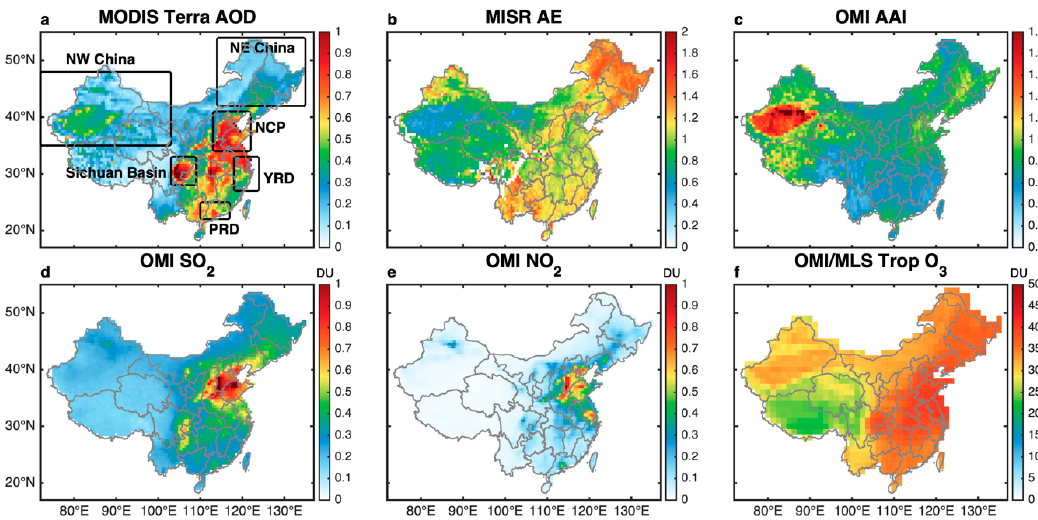
Figure 1. Spatial distribution of annual mean MODIS Terra AOD ( a ), MISR AE ( b ), OMI AAI ( c ), OMI SO 2 ( d ) and NO 2 ( e ), and OMI/MLS tropospheric O 3 ( f ). The black boxes in panel ( a ) indicate the representative regions defined for regional analysis, namely NCP, NE China, NW China, YRD, PRD, and the Sichuan Basin.